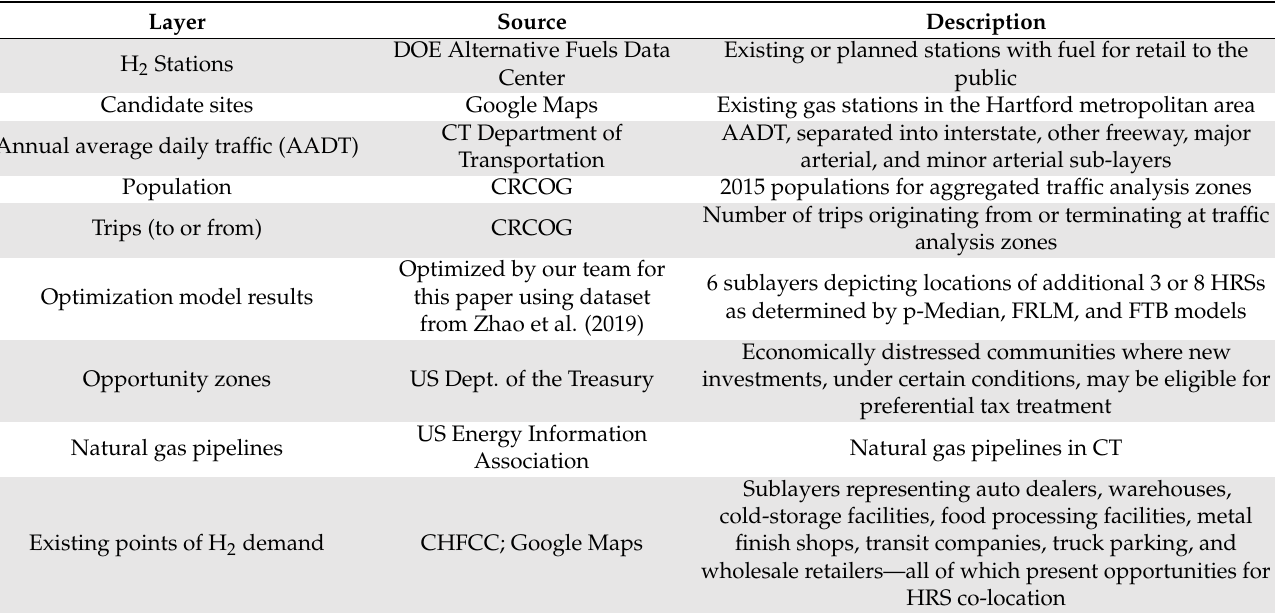
Table 3. Spatial Data Layers in the Collablocation